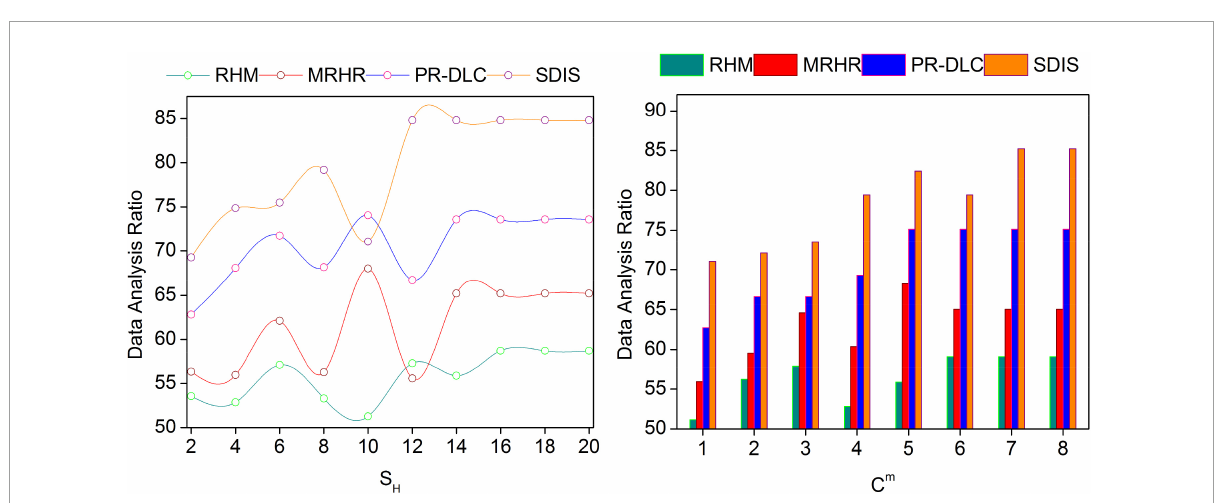
FIGURE7 Data analysis ratio